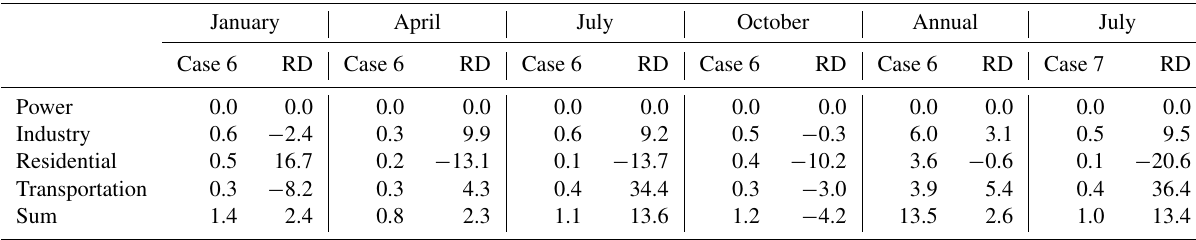
Table 6. The monthly and annual emissions by sector for southern Jiangsu 2015 in Cases 6 and 7 (unit: Gg) and the relative deviation compared to JS-posterior (RD: Case 6 or 7–JS-posterior) / JS-posterior,